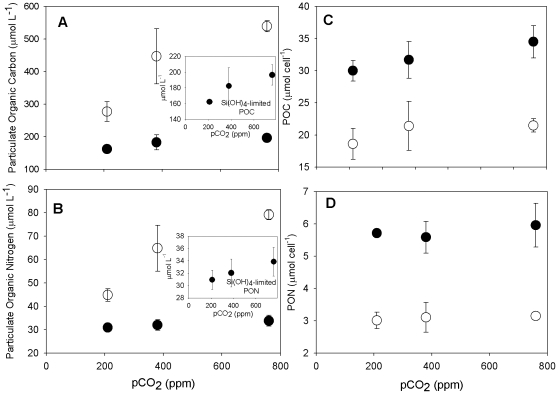
Steady-state particulate organic carbon (POC) (a) and nitrogen (PON) (b) concentrations (µmol L−1), particulate organic carbon (POC) (c) and nitrogen (PON) (d) cell quotas (mol cell−1) in semi-continuous Pseudo-nitzschia fraudulenta cultures grown under Si(OH)4-limited (black circles, •) and nutrient-replete (open circles, ○) conditions at three seawater CO2 concentrations (200, 360 and 765 ppm).Panel insets present the Si(OH)4-limited data with an expanded Y-axis scale for clarity. Error bars represent standard deviations of triplicates for each treatment.